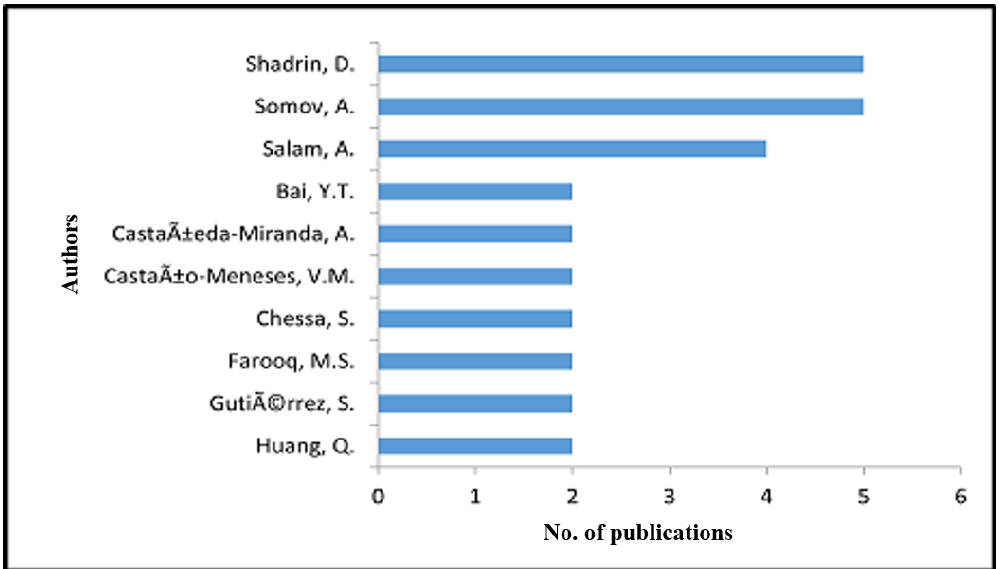
Figure 10. Top ten authors contributing to research area of IoT in